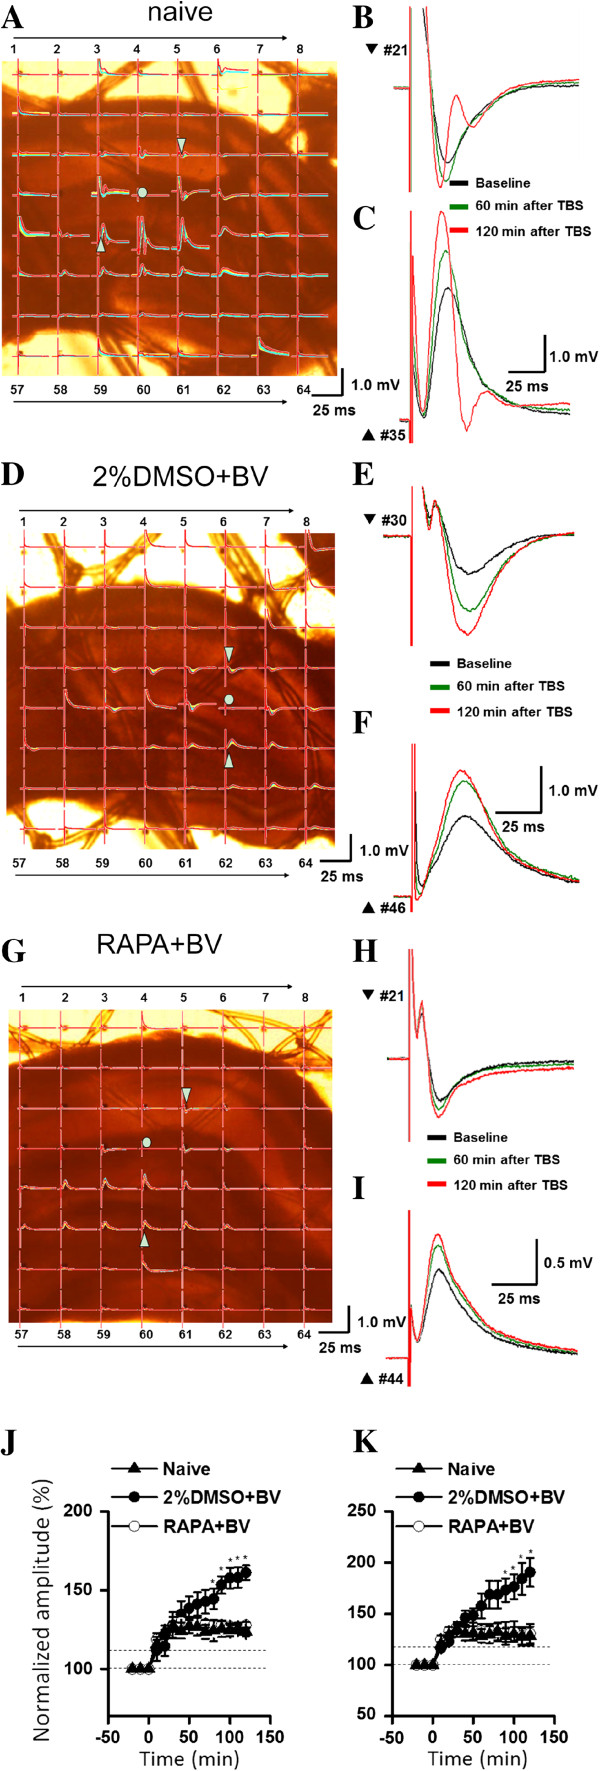
Multichannel recording of field excitatory postsynaptic potentials (fEPSPs) in hippocampal slices from 2%DMSO + BV and RAPA + BV groups before and after theta burst stimulation. (A-C) Responses from a naive group rat (A) Photograph showing the hippocampal formation from a naïve group rat and Med-64 probe with 8 × 8 array. The asterisk indicates an electrode selected for electrical stimulation of the perforant path (PP) fibers. Real traces of 63 recording electrodes across the DG and the CA1 area in response to perforant path (PP) test stimulation before (black), 60 min after (green), and 120 min (red) after TBS. The PP-evoked network FP responses were localized in both the DG and CA1. (B) fEPSPs are negative-going (lower) in CA1. (C) fEPSPs are positive-going (upper) in the DG. fEPSP amplitudes in these two areas were potentiated by TBS stimulation of PP fibers (asterisk). Scale bar applies to both sweep sets. (D-F) Micrograph of a hippocampal slice and evoked responses from a 2%DMSO + BV group rat. (G-I) Hippocampal slices and typical sample recordings from a RAPA + BV-treated rat. (J and K) Summary of LTP experiments in hippocampal slices from naive, 2%DMSO + BV and RAPA + BV groups. The amplitude of both the DG (J) and CA1 (K) fEPSPs was normalized to pre-TBS baseline. The data were showed as means ± SD (n = 7). *P < 0.05, RAPA + BV group vs. 2%DMSO + BV group.